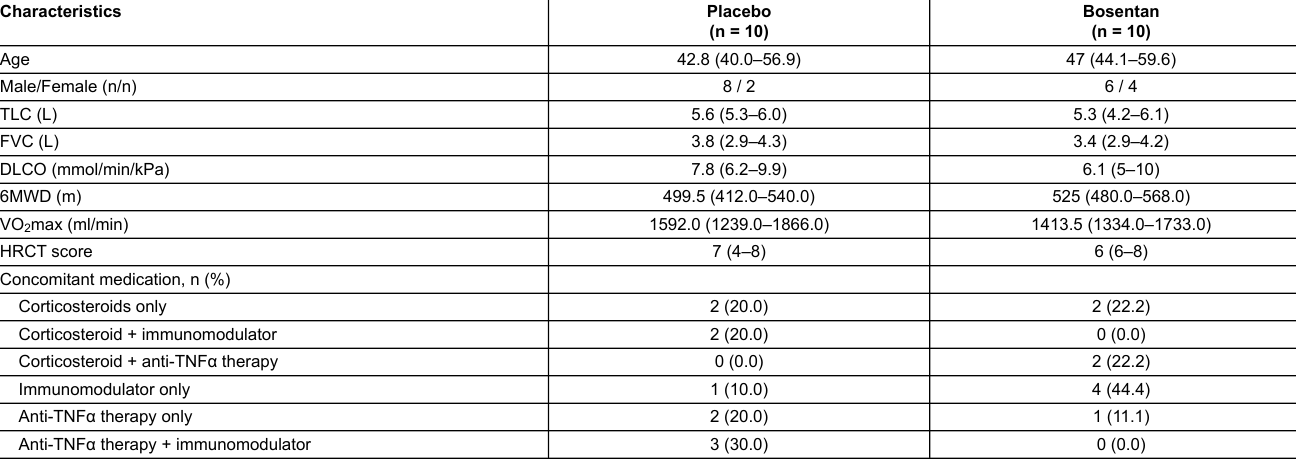
Table 1: Baseline demographics, pulmonary function tests, high resolution computed tomography score and concomitant medication. Characteristics